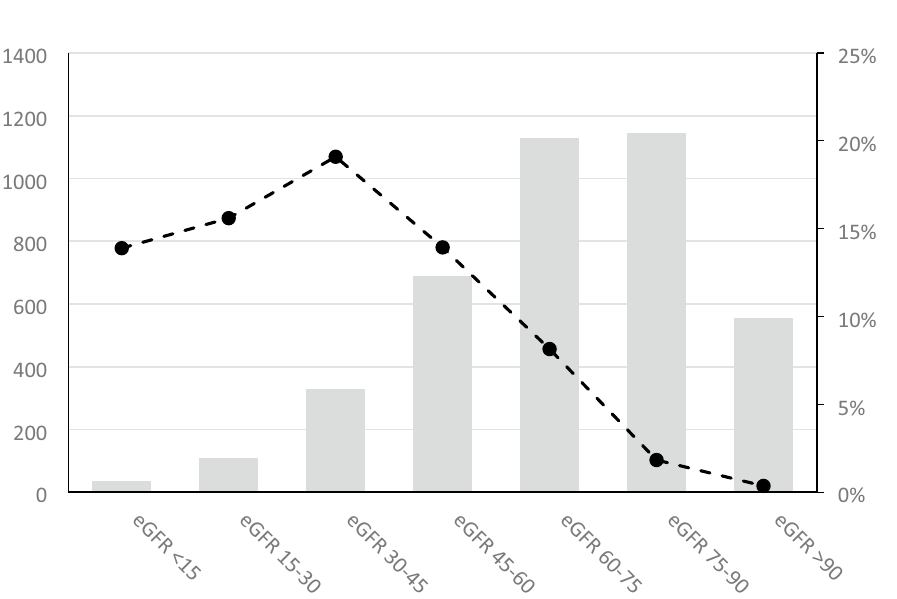
Figure 2. The study population in different mean eGFR strata, all in ml/min/1.73 m 2 , number of patients on the y-axis to the left. The dotted line depicts the distribution of patients with SPS in the different mean eGFR strata in percent on the y-axis to the right. eGFR estimated glomerular filtration rate, SPS shrunken pore